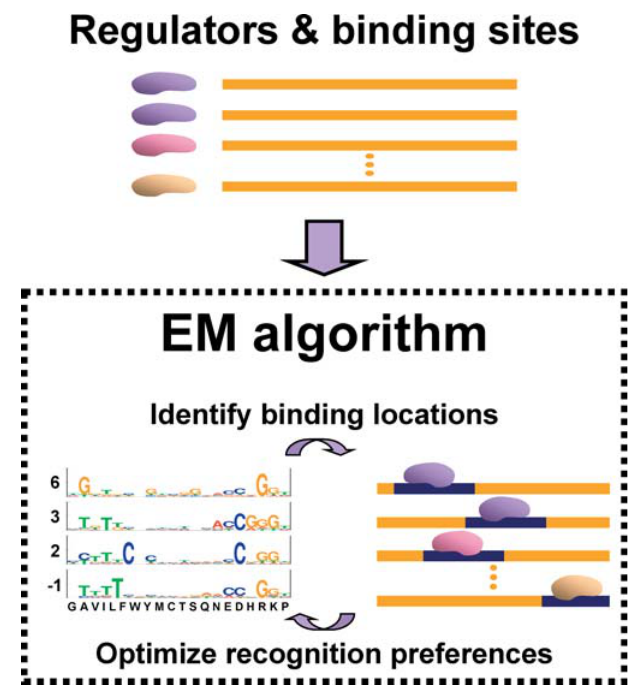
Figure 2. Estimating DNA-Recognition Preferences The DNA-recognition preferences are estimated from unaligned pairs of transcription factors and their DNA targets [2] (above). The EM algorithm [13] is used to simultaneously assess the exact binding positions of each protein–DNA pair (bottom right), and to estimate four sets of position- specific DNA-recognition preferences (bottom left). DOI: 10.1371/journal.pcbi.0010001.g002